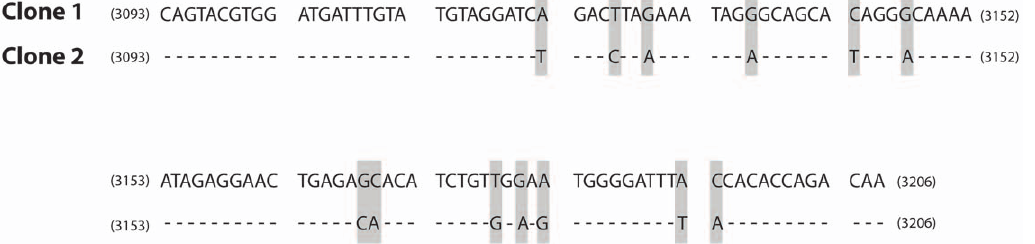
Figure 1. Nucleotide sequence alignment of clone 1 and clone 2. The clones cover position 3093–3206 in HXB2 and were used for the mixing experiments. The clones differed by 13 informative sites that are highlighted in gray.